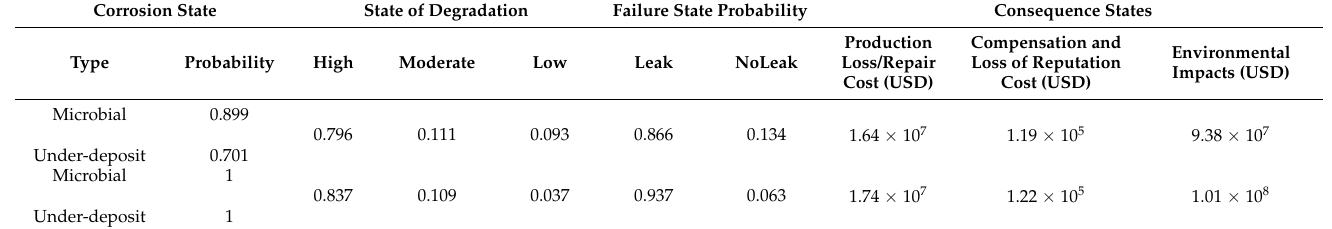
8 of 11 Figure 4. Impact of complex interaction on the failure state and the predicted economic losses. Table 1. Results of the parametric learning and evidence-based analysis of the case study. Corrosion State State of Degradation Failure State Probability Consequence States Type Leak